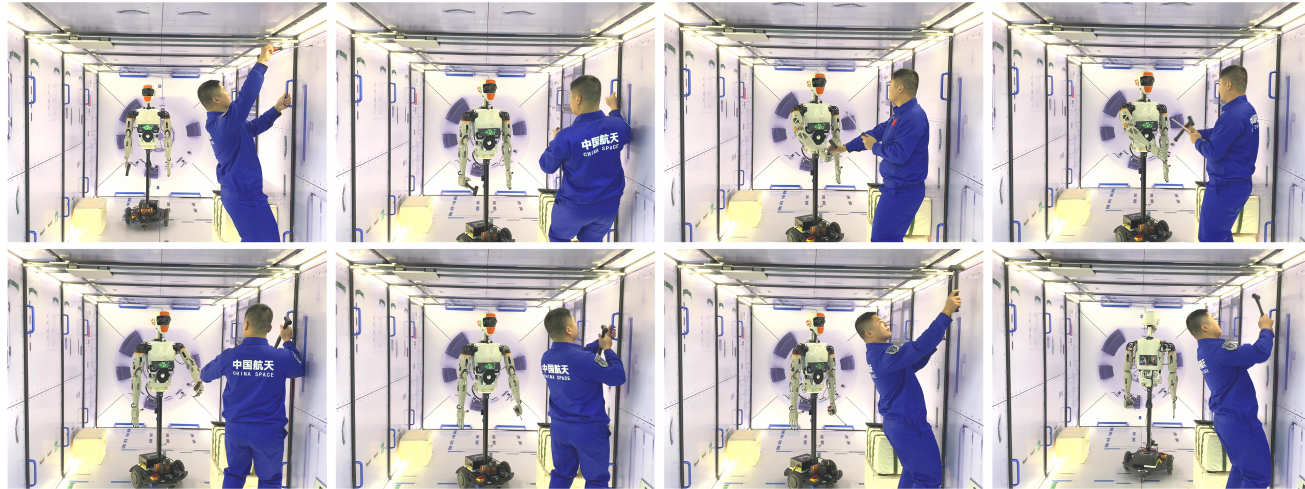
Figure 12. Taikobot works side by side with a volunteer astronaut and helps deliver